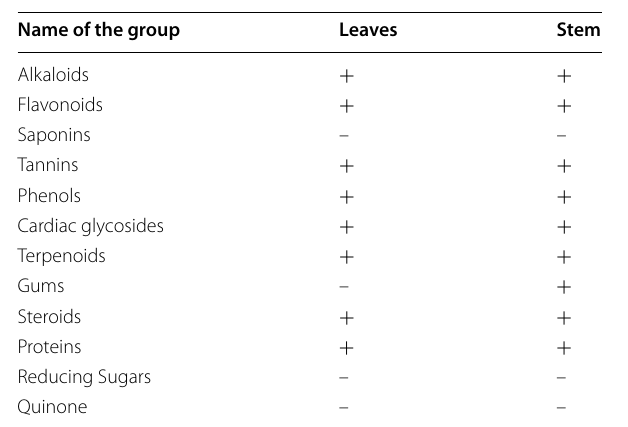
Table 1 Phytochemical analysis in the ethanolic extract of P. minima